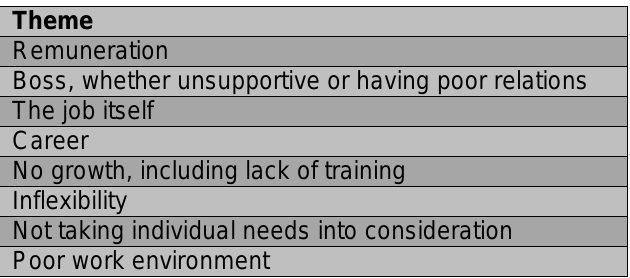
Table 2: Themes for leaving the